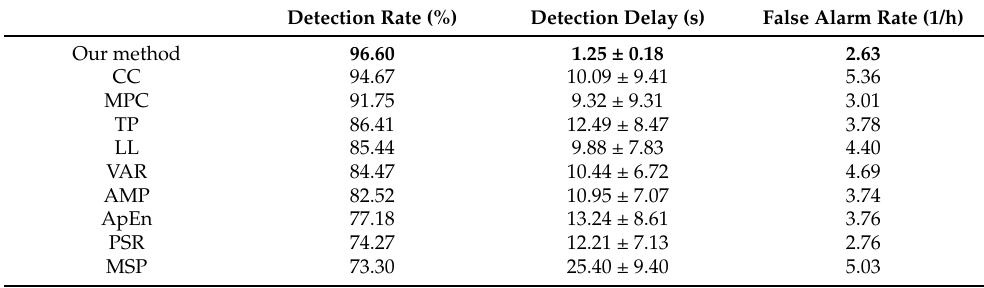
Table 4. Detection